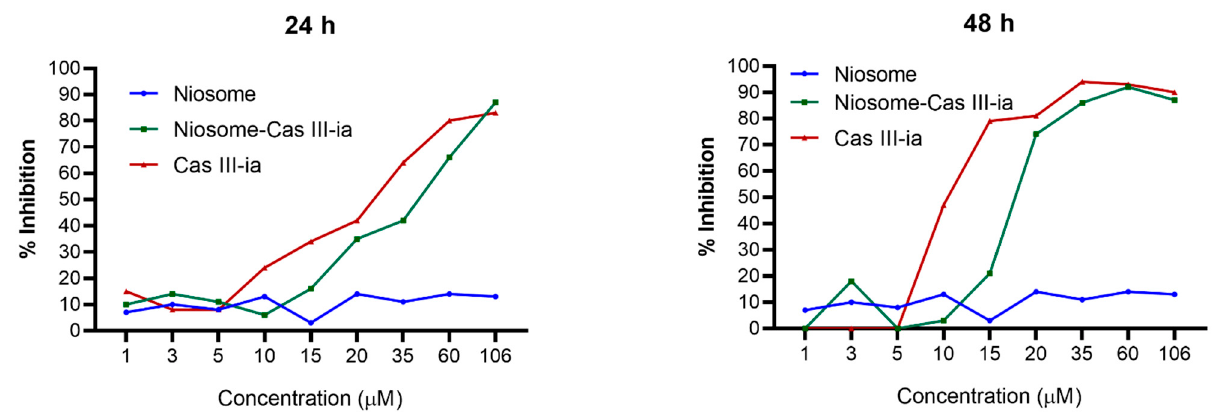
Figure 8. Cytotoxic effect of MDA-MB-231 cell line treated with free CasIII—ia, CasIII—ia niosomal formulation, and niosome blank at different concentrations and times.